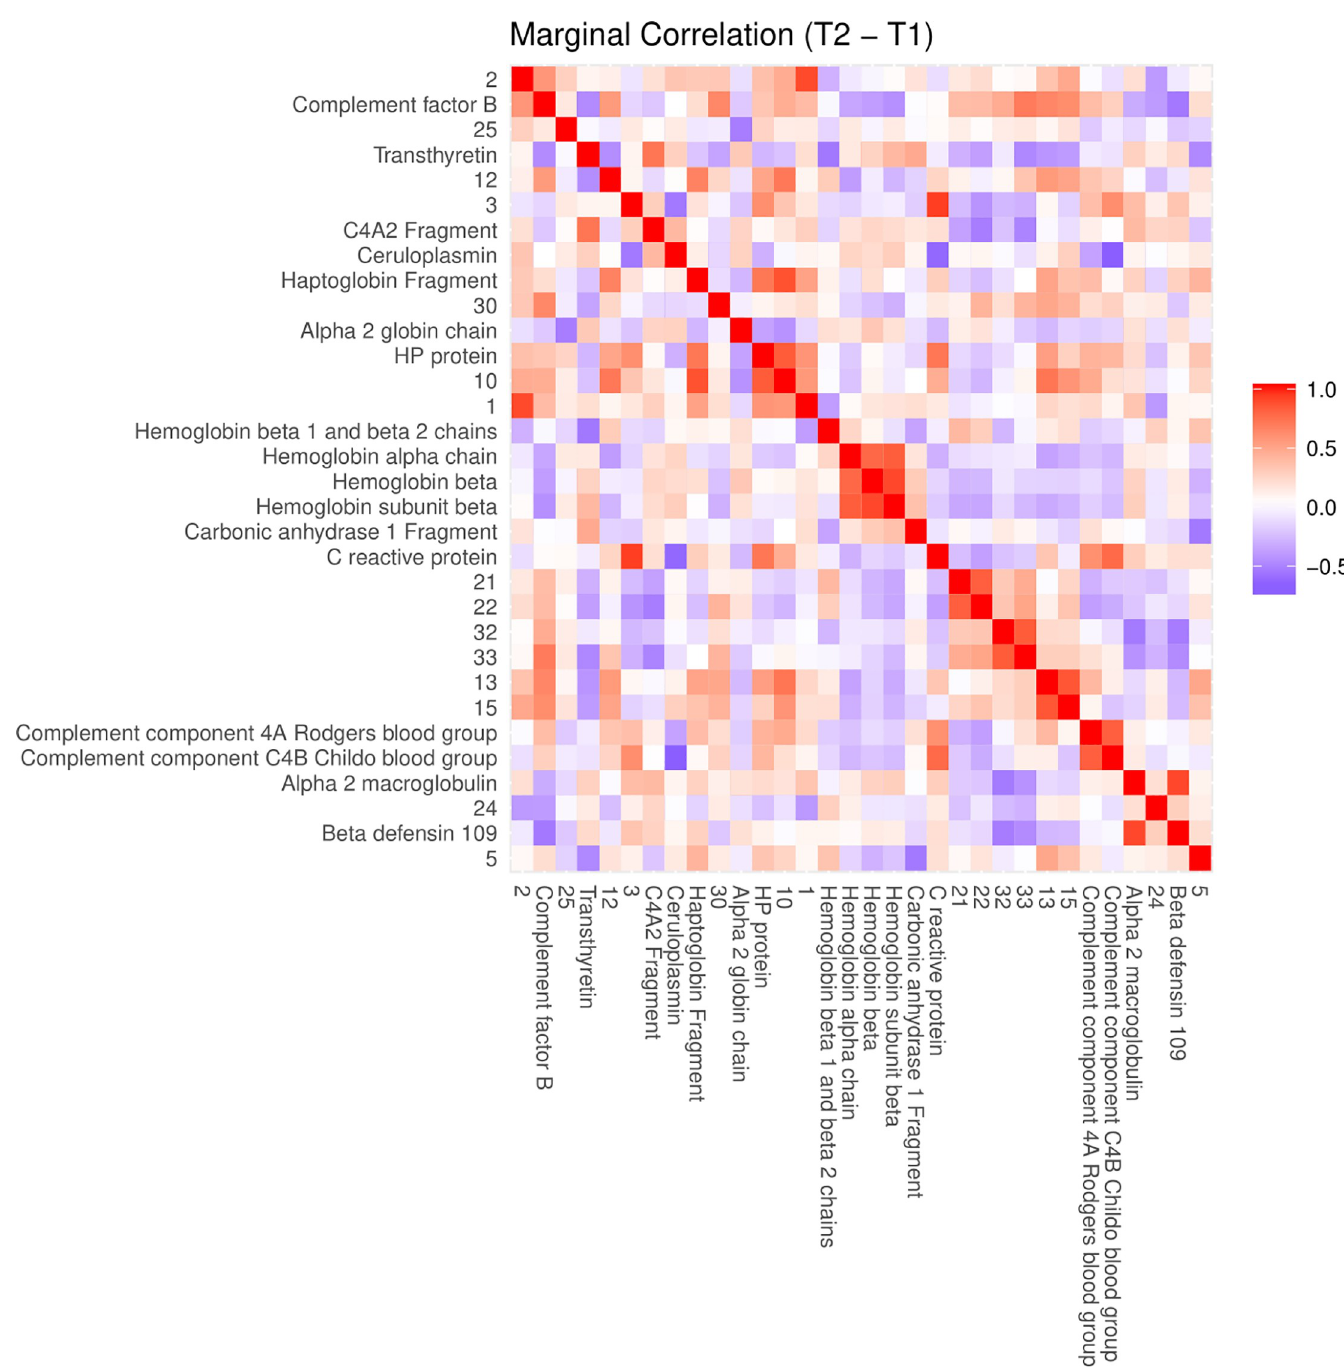
Fig 4. An ordinary heatmap of marginal correlations between differences in spot intensities from t 1 to t 2 . Row and column order were set by hierarchical clustering using f ( x ) = 1 − cor ( x )as distance function. Color represents positive (red) or negative (blue) correlations. Heatmaps corresponding to the other time point transitions are included as supplementary figures (S20, S21 and S22